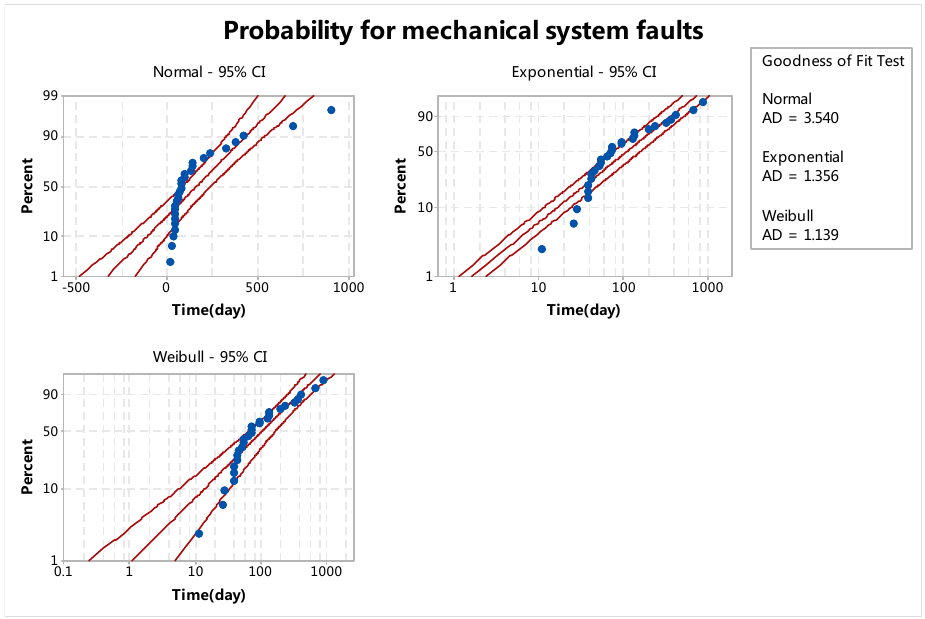
Figure 15. Goodness of fit test for mechanical system fault.